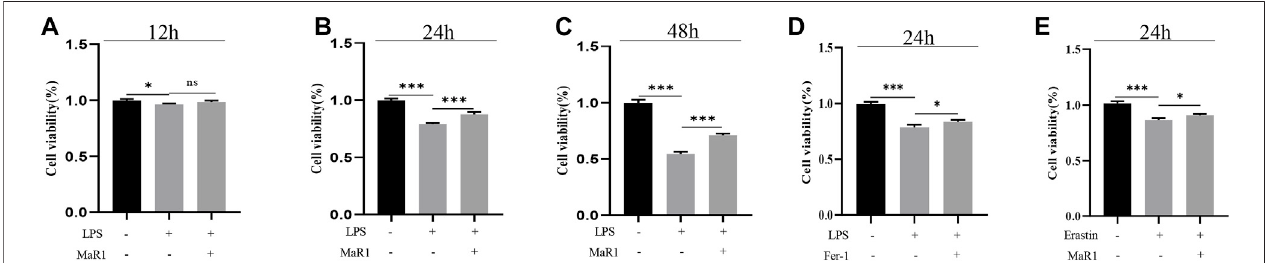
FIGURE 5 | MaR1 suppressed LPS-induced and erastin-induced ferroptosis in vitro . (A – C) MTT assay showed that MaR1 inhibited HepG2 cell death caused by LPS at 12, 24,and 48 h. (D) Fer-1 inhibited LPS-induced cell death. (E) MaR1 inhibited cell death caused byerastin. Dataare shown as the mean ±SD, * p < 0.05; ** p < 0.01; *** p < 0.001.